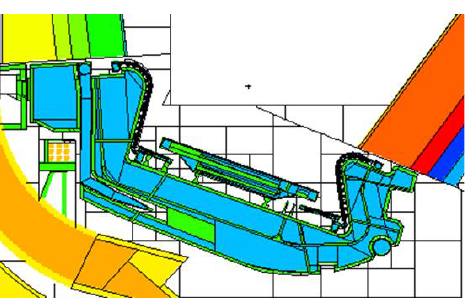
Figure 5. Fully heterogeneous divertor 2019 MCNP representation (poloidal section).